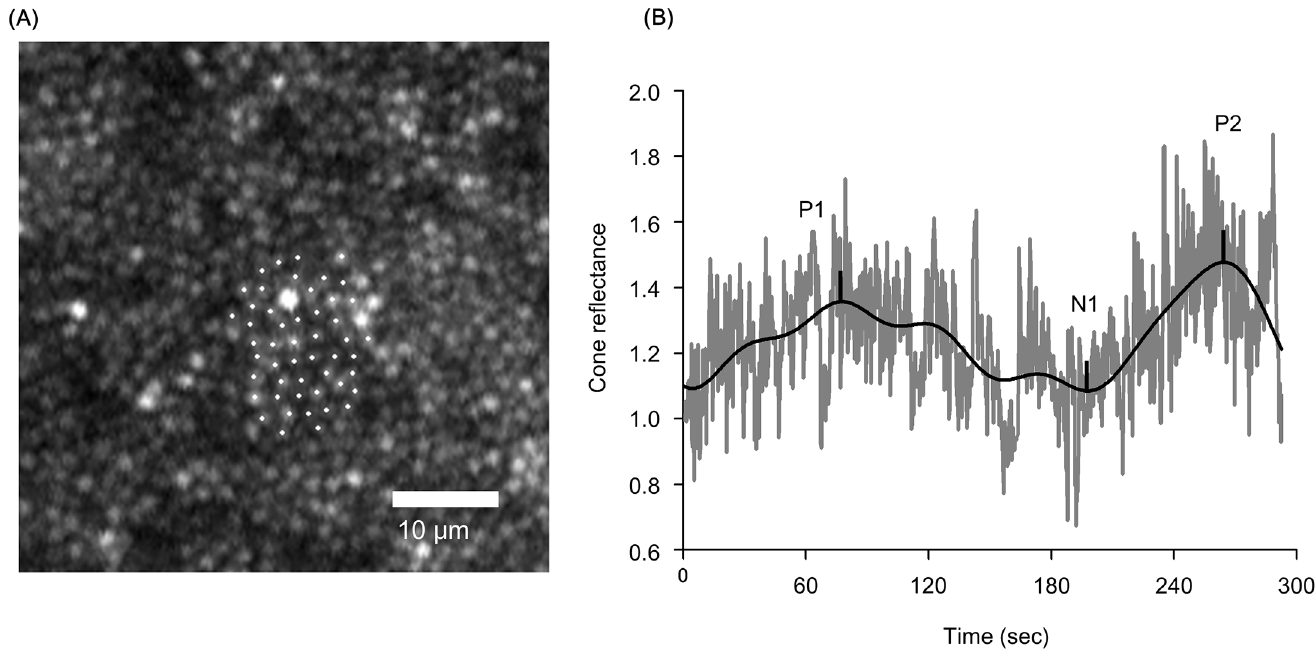
Fig 2. Individual cone reflectance changes during light stimulation. A. AO-SLO image with high magnification (1° * 1°) at 1° temporal from the fovea in Subject 2. White dots represent the 50 cones in which reflectance changes were measured. B. Average of the individual cone reflectance changes during light stimulation. The dark gray lines indicate the raw data. The black line shows the low-pass filtered data at 0.008-Hz. The average cone reflectance changes had two peaks. P1, first positive peak; N1, first negative trough; P2, second positive